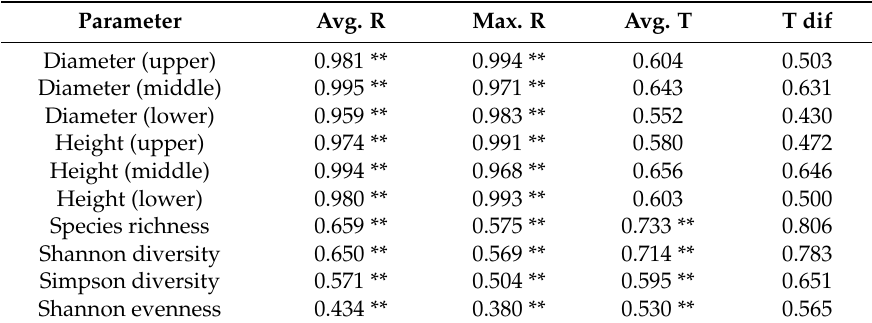
Table 5. Pearson correlation coefficients of species richness, diversity and forest structure relative to environmental